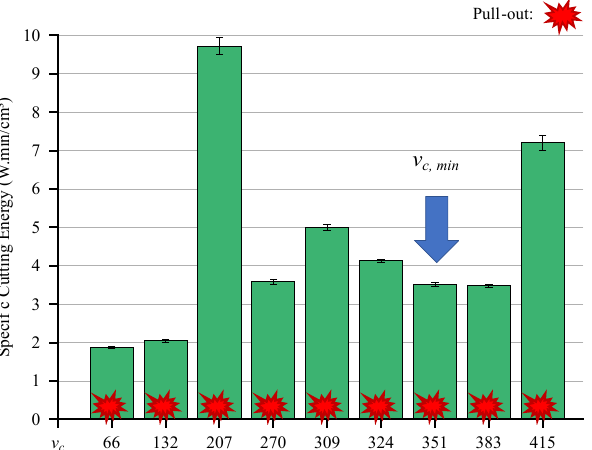
Figure 21. Determination of the minimal cutting speed of the universal tool, the evolution of the specific cutting energy (W · min/cm 3 ) for different v c (m/min) with f z = 0.030 mm/tooth, a p = 3 mm, and a e = 0.5